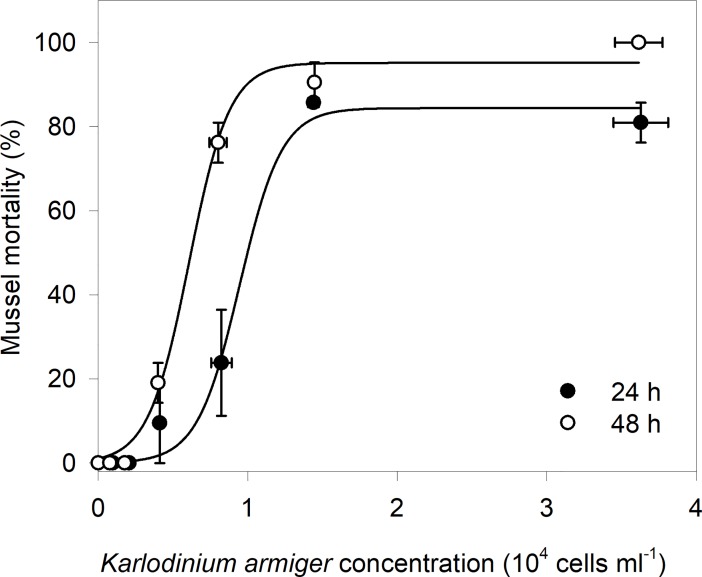
Mortality of Mytilus edulis exposed to six Karlodinium armiger concentrations for 24 and 48 h.LC50 values of 9.4·103 ± 2.7·103 cells ml-1 and 6.1·103 ± 0.3 ·103 cells ml-1 were found after 24 and 48 h, respectively. Data presented as mean values with SE bars.